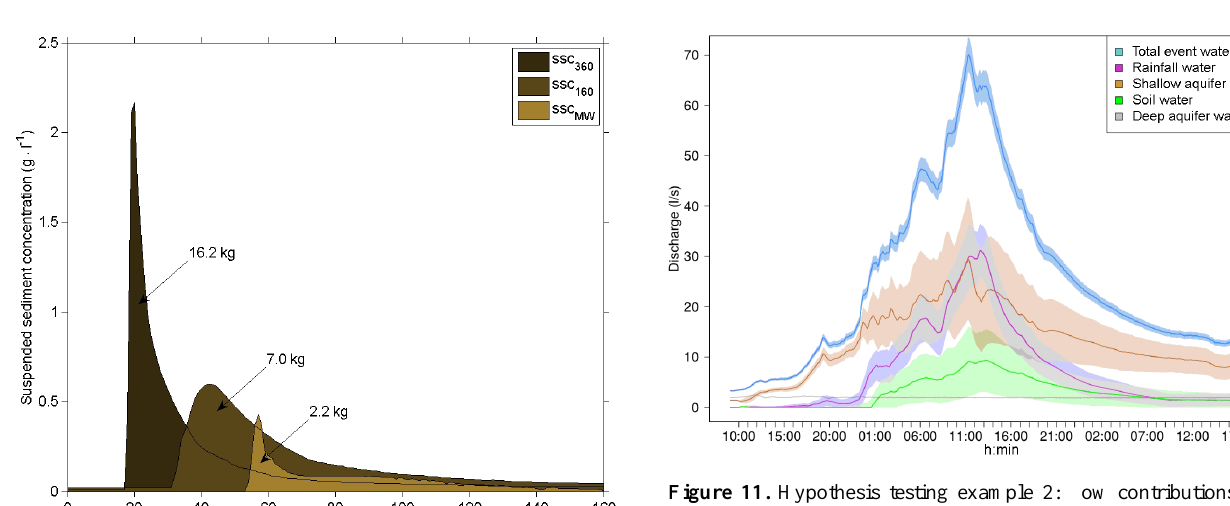
Figure 11. Hypothesis testing example 2: flow contributions for the event on 20 January 2012 at MW including uncertainties. End- member mixing analysis (EMMA) was applied in a Monte Carlo mode with given error distributions on the concentrations and dis- charges which translate into the uncertainty distributions shown as shaded areas in the graph. See Exner-Kittridge et al. (2016) for de-